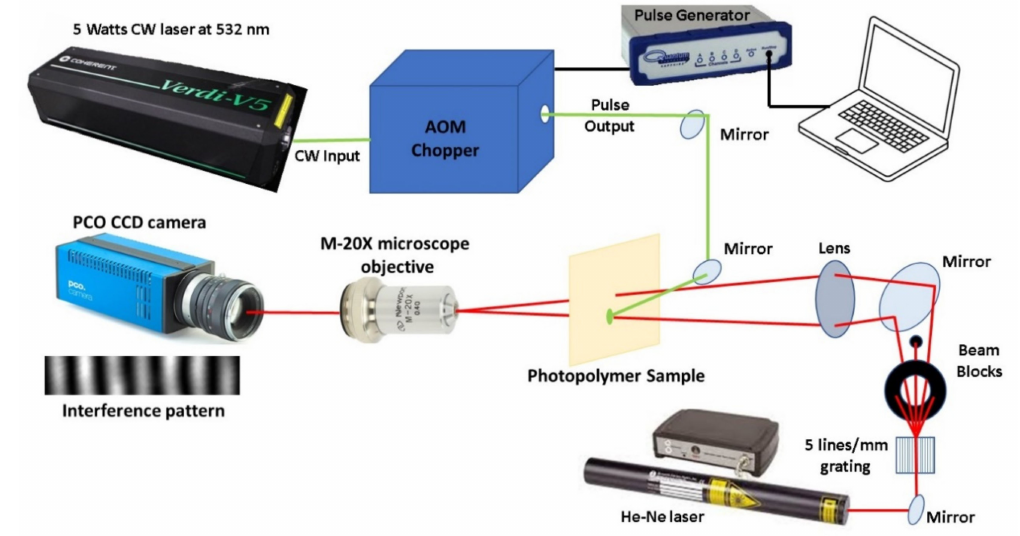
Figure 1. Experimental setup of the irradiation